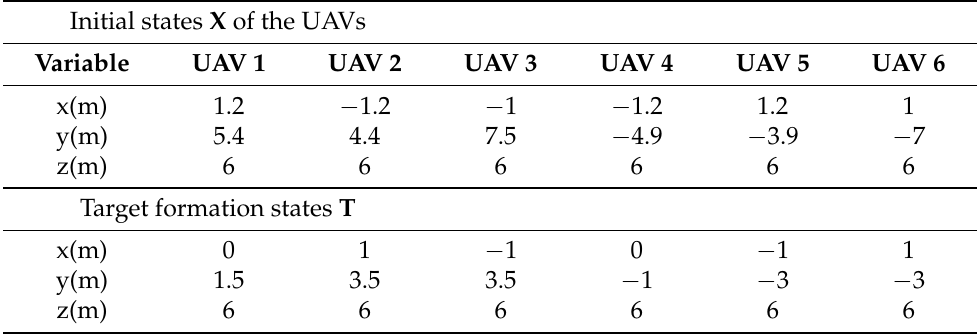
Table 6. Coordinates of the initial and target formations.